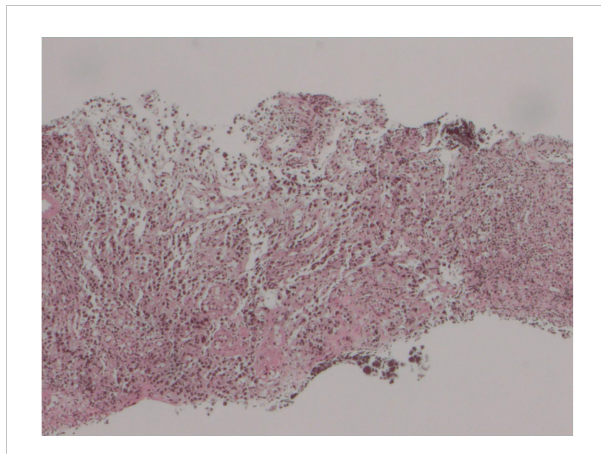
FIGURE 3 The pathological fi ndings showed that there were nests of abnormal cells, accompanied by pigmentation (H&E,